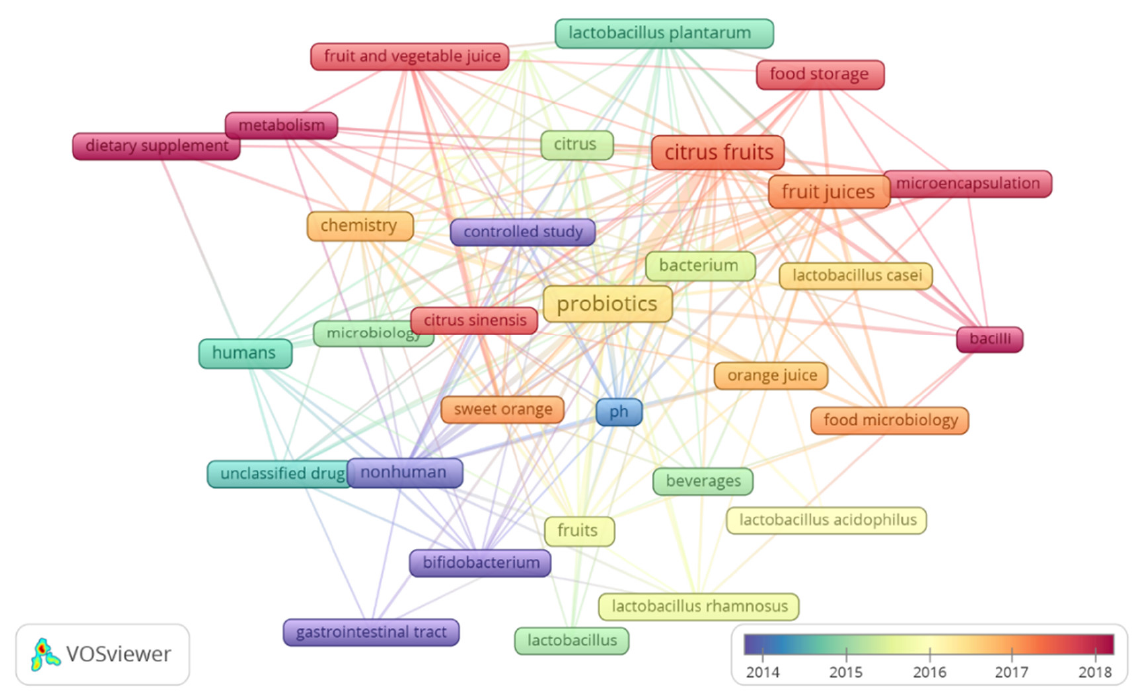
Figure 3. Keyword network visualization map according to co-occurrence. Each frame represents the keywords. The frame size indicates its frequency of occurrence. The count of citations received by articles that contain the term or phrase by year is represented according to a color scale. The closest frames indicate the terms that co-occurred most frequently over the years.